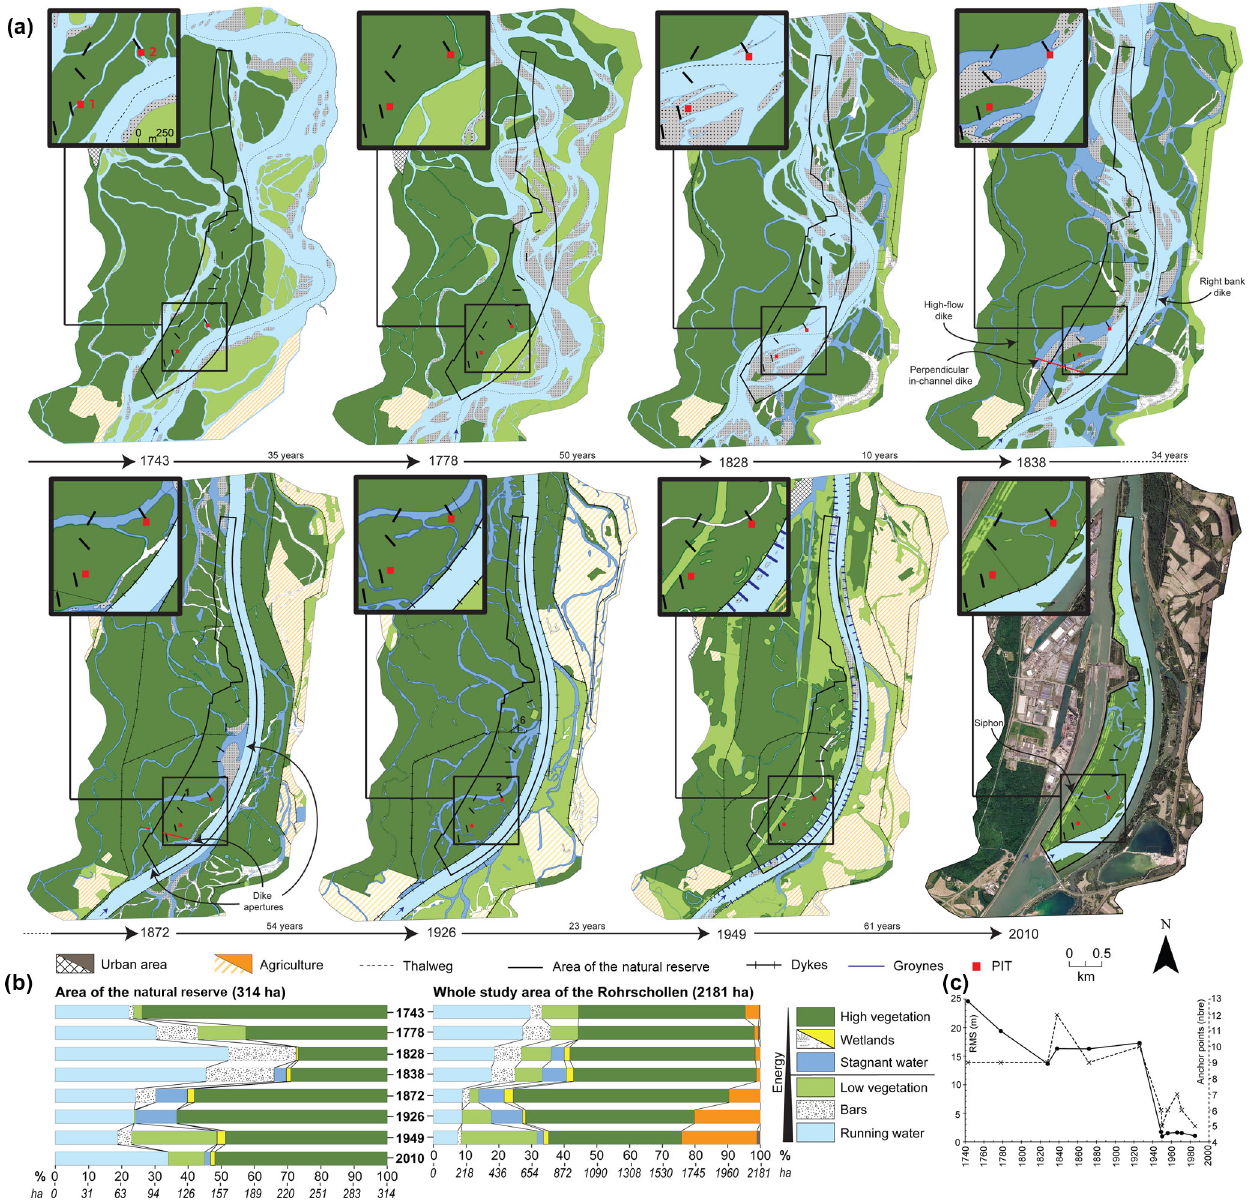
Figure 4. (a) Diachronic evolution of the whole study area. The black boxes are zooms (scale 1:2) of the surroundings of the two pits. (b) Sur- face evolutions of the morpho-ecological units in the natural reserve (1743–2010) and in the whole study area (1743–1949). (c) Number of anchor points used to georeference old maps and aerial photographs (dotted line) and values of RMSEs (continuous